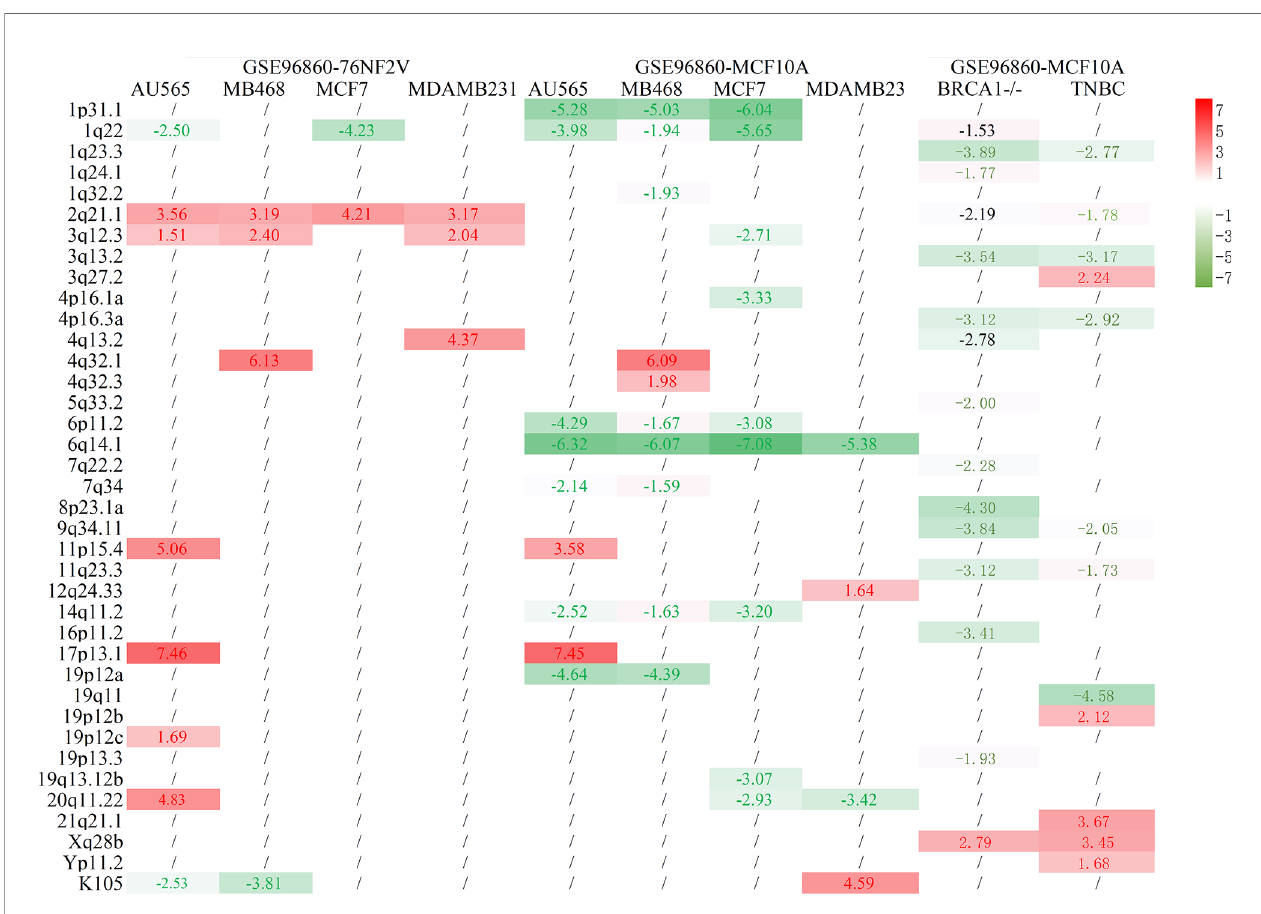
FIGURE 1 | Statistical results of BCa and normal control cells. The row is the loci of HERV-K proviruses, and the column is the cell